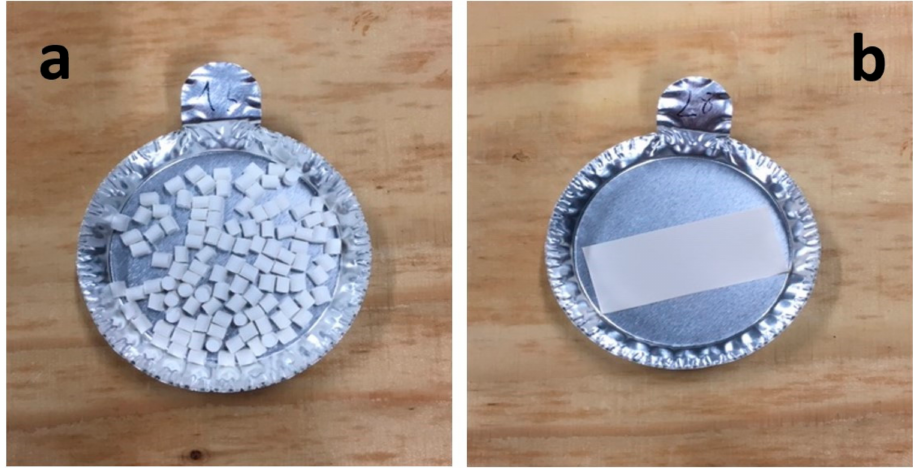
Figure 9. Sample layout for ( a ) granulates and ( b ) molded part